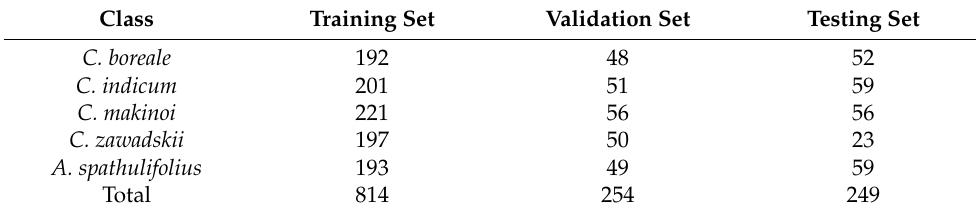
Table 1. Detailed explanation of the dataset used in this study.